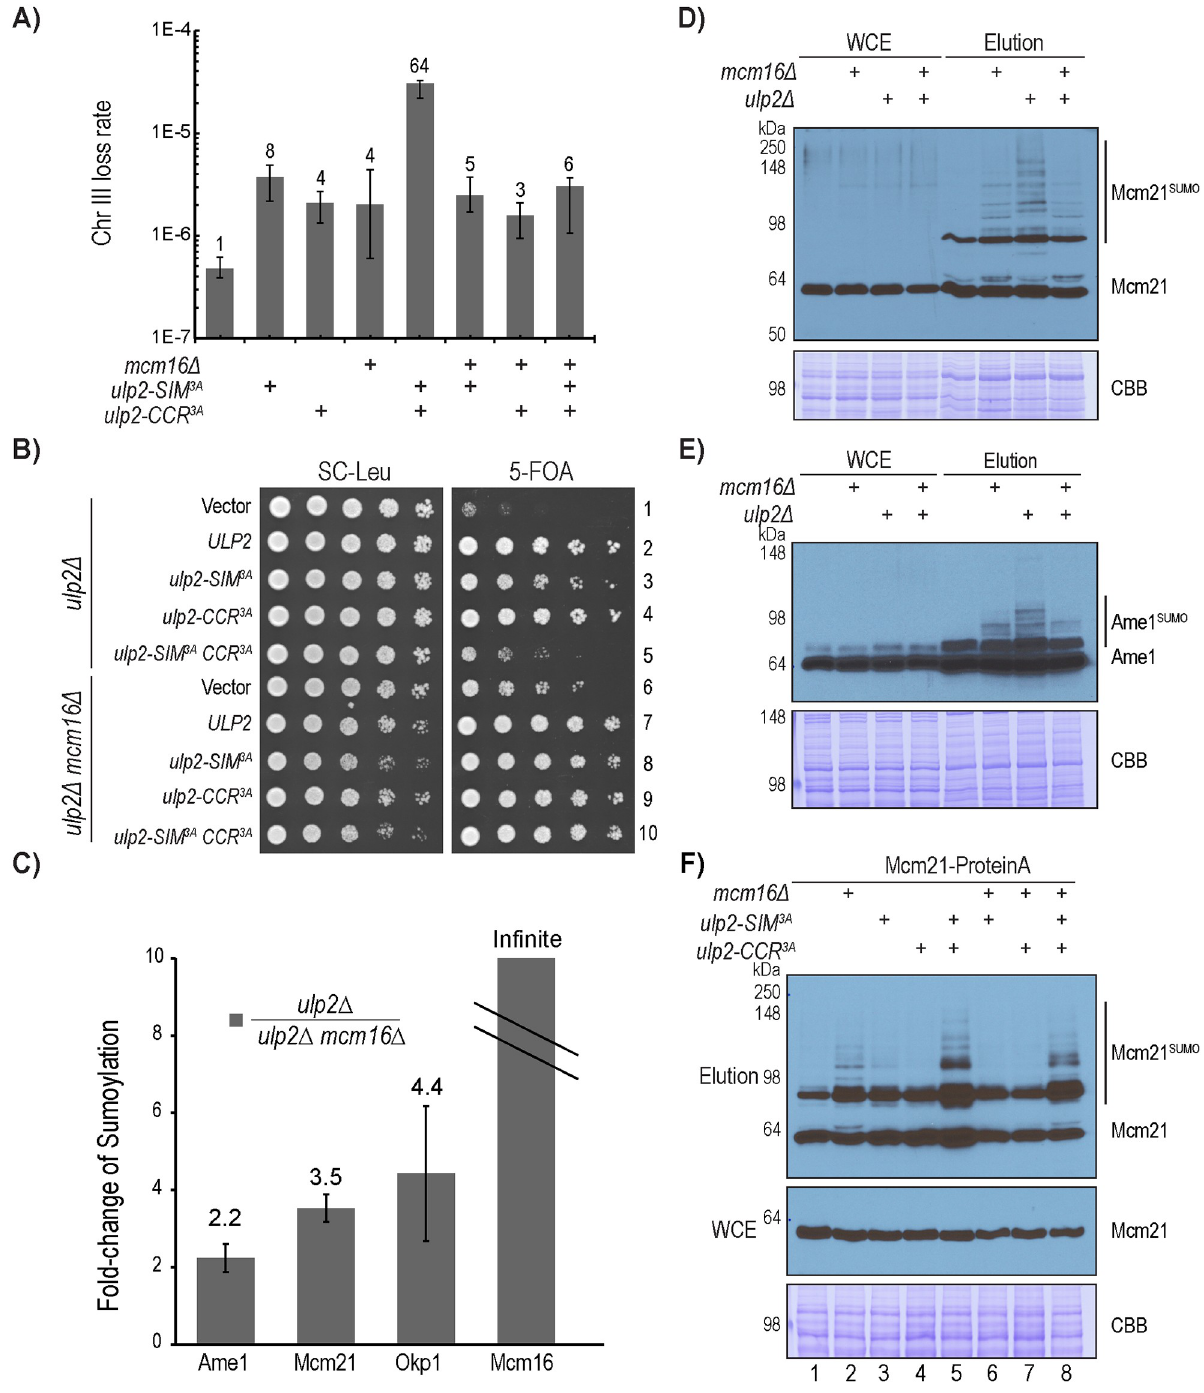
Fig 5. Mcm16 plays a dual role in regulating CCAN sumoylation. A) Chromosome loss rates of WT, ulp2-SIM 3A , ulp2-CCR 3A , ulp2-SIM 3A CCR 3A